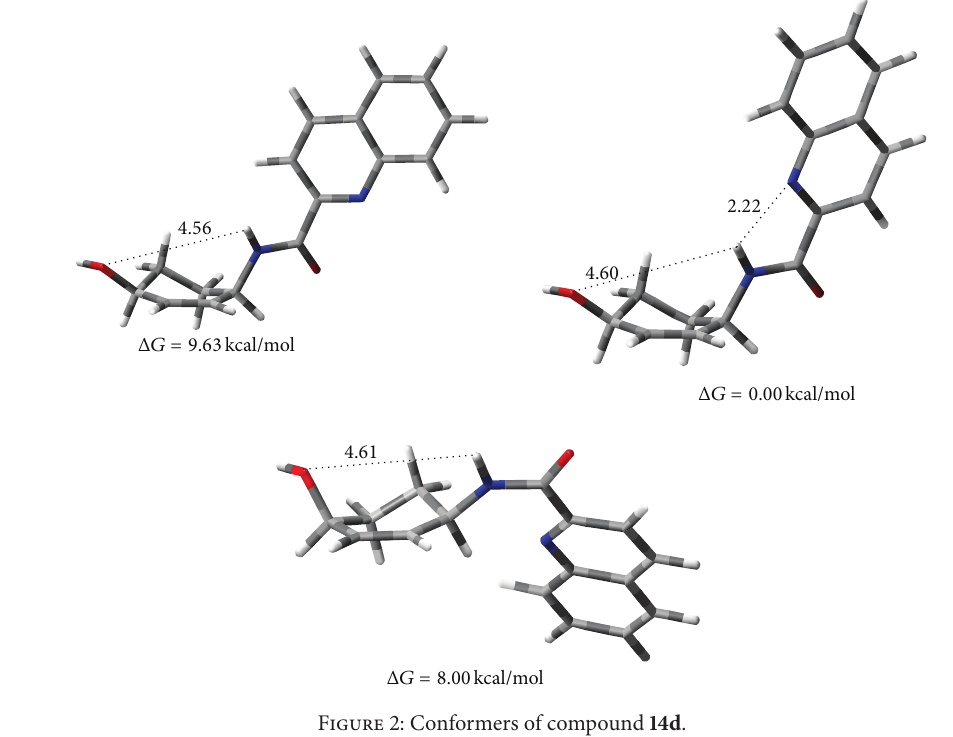
Figure 2: Conformers of compound 14d